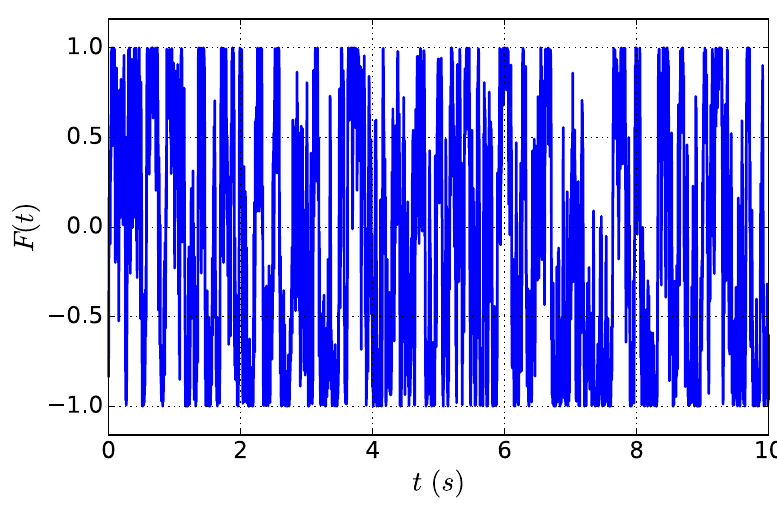
Figure 3. Time delay 𝜏(𝑡) .